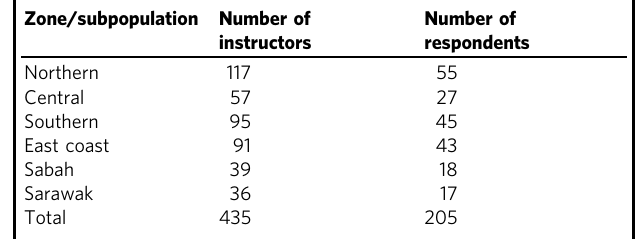
Table 2 The sample size according to the zones.